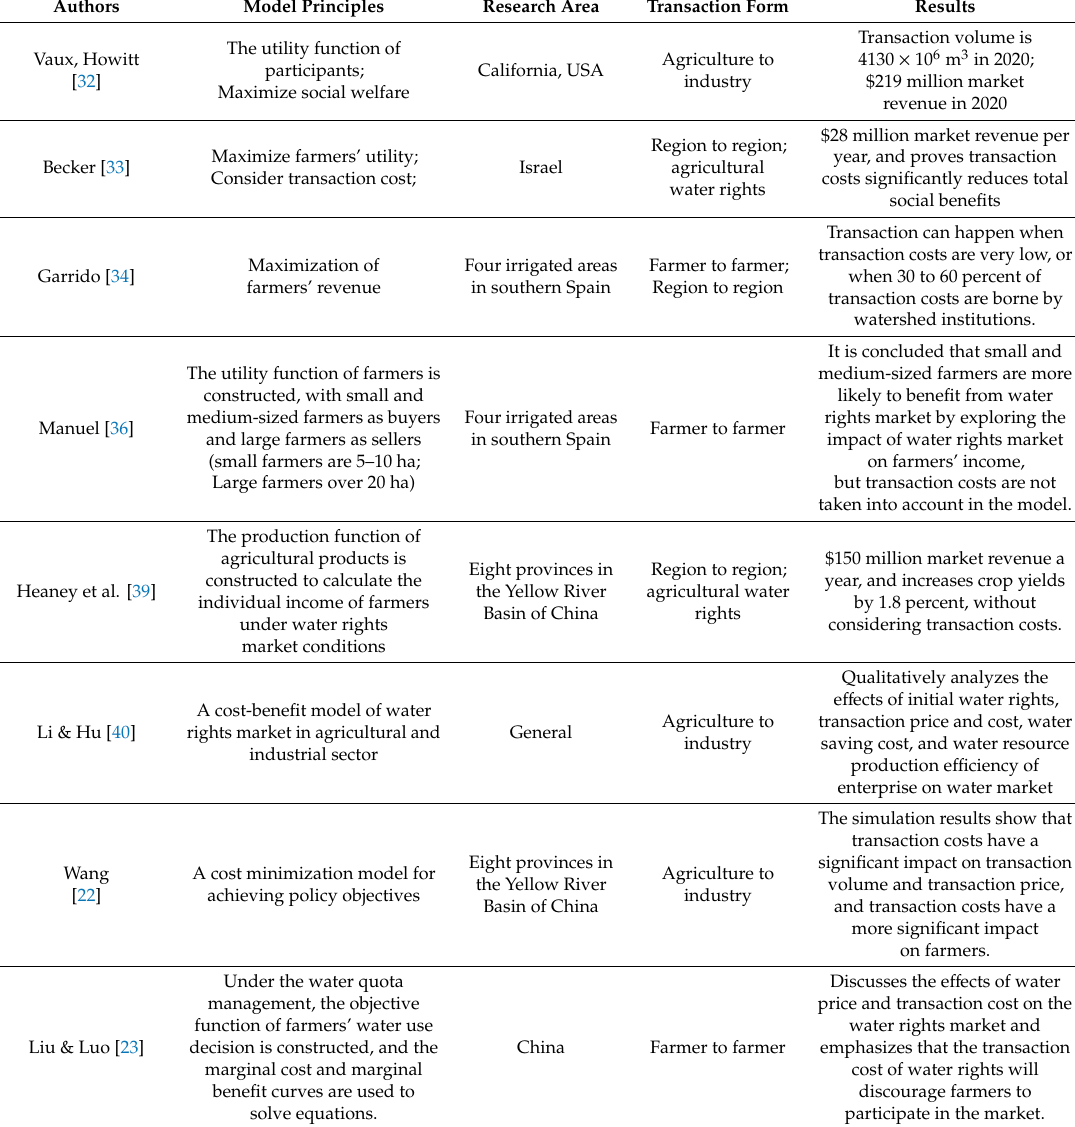
Table 1. Important mathematical models in the